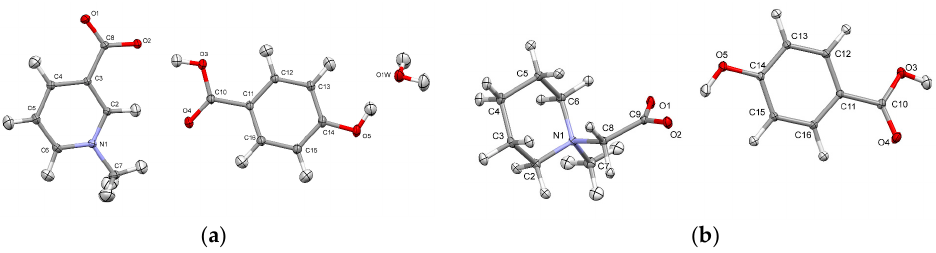
Figure 1. Perspective views of the components of crystal structures 1 ( a ) and 2 ( b ), together with atom numbering schemes; the ellipsoids are drawn at the 50% probability level, anisotropic thermal parameters for hydrogen atoms were calculated with SHADE server (cf. Experimental part).